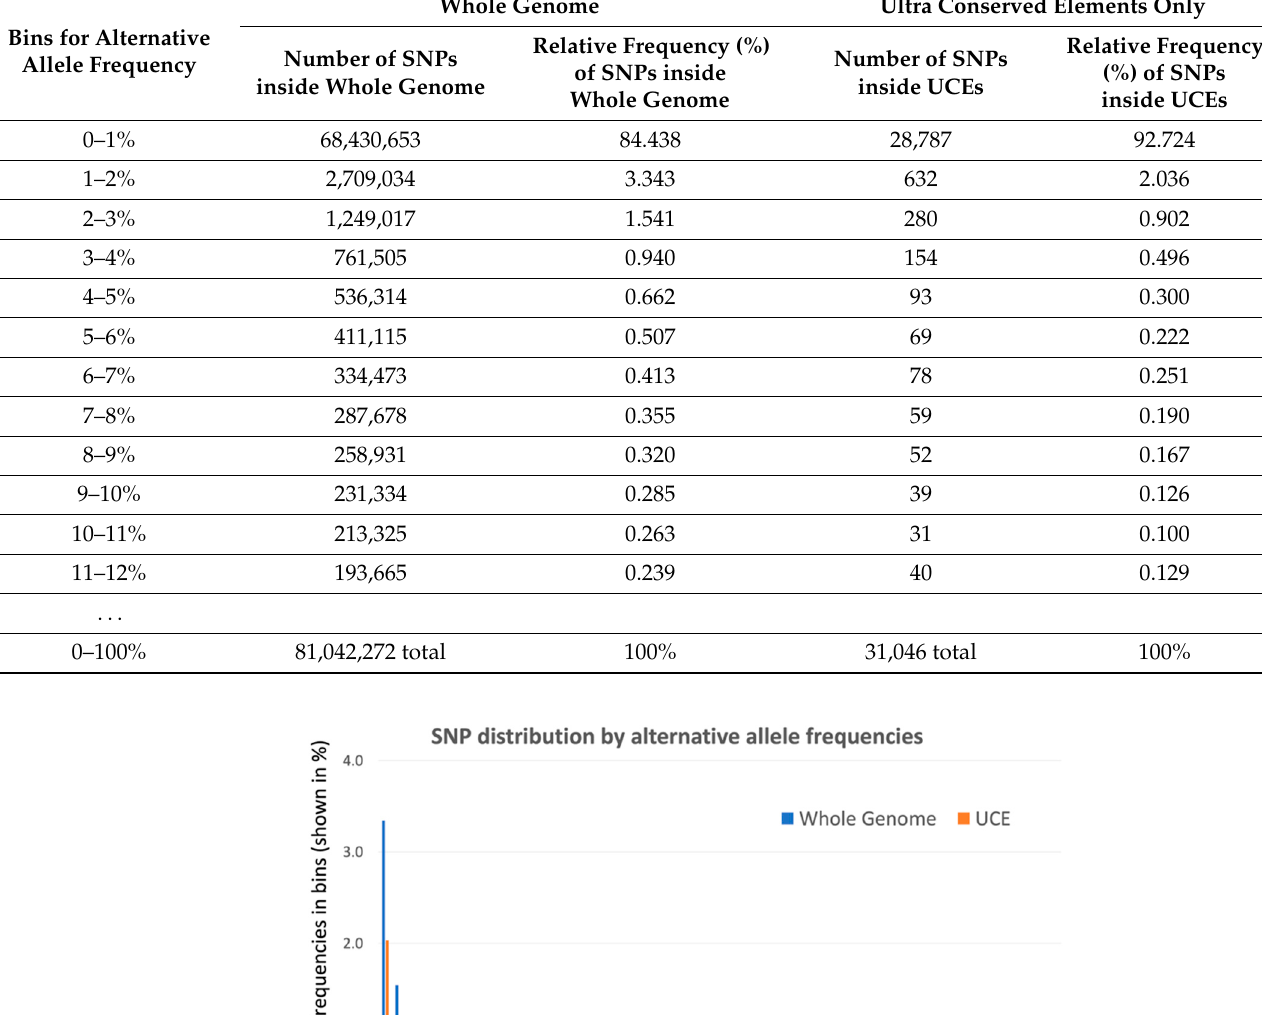
Table 1. Distribution of SNPs by their alternative allele frequencies inside UCNEs and the whole genome. SNPs are divided into one hundred bins by their alternative allele frequencies shown in column one. Columns 2 and 4 show the number of SNPs in the corresponding bin inside the whole genome and UCNEs, respectively. Columns 3 and 5 show the relative frequencies of SNPs in the bins by dividing the number of SNPs in the bin by the total number of analyzed SNPs in the whole genome and UCNEs, respectively. The entire table for 100 bins is shown in the Supplementary Table S1. The graphic of distribution of relative frequencies of SNPs (columns 3 and 5) inside the bins is illustrated in Figure 1.